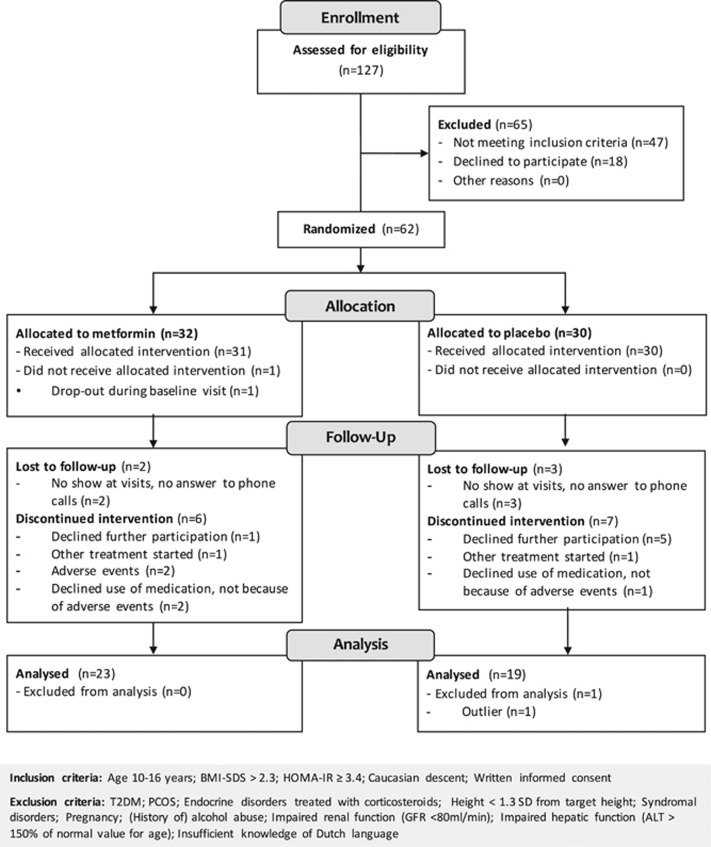
Consort flow diagram.